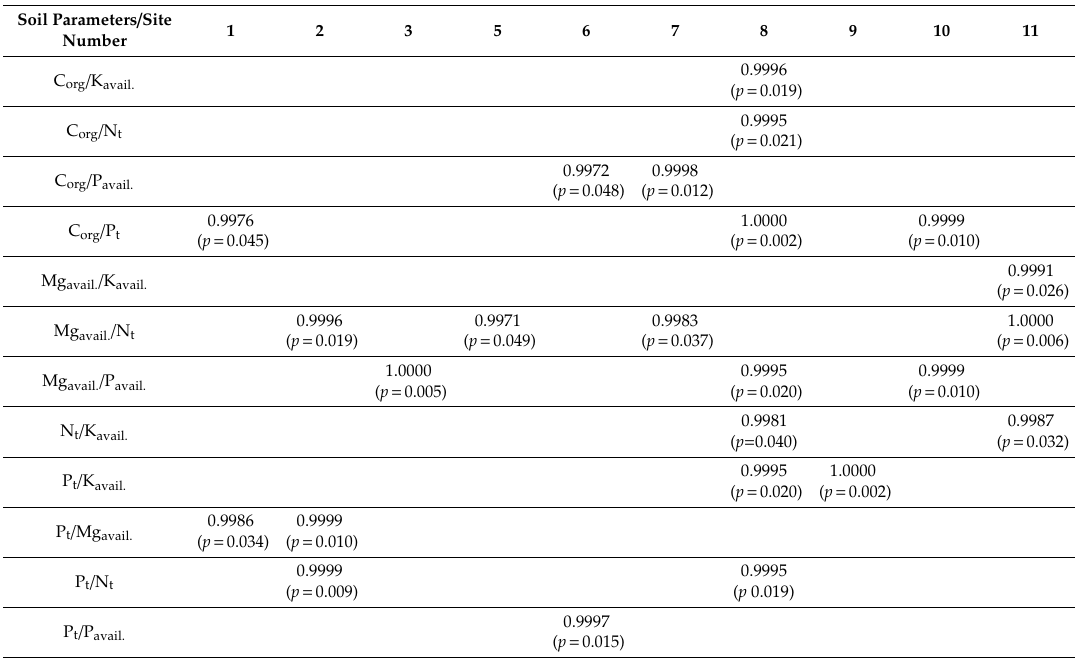
Table 5. Correlation coe ffi cient and significance level at selected